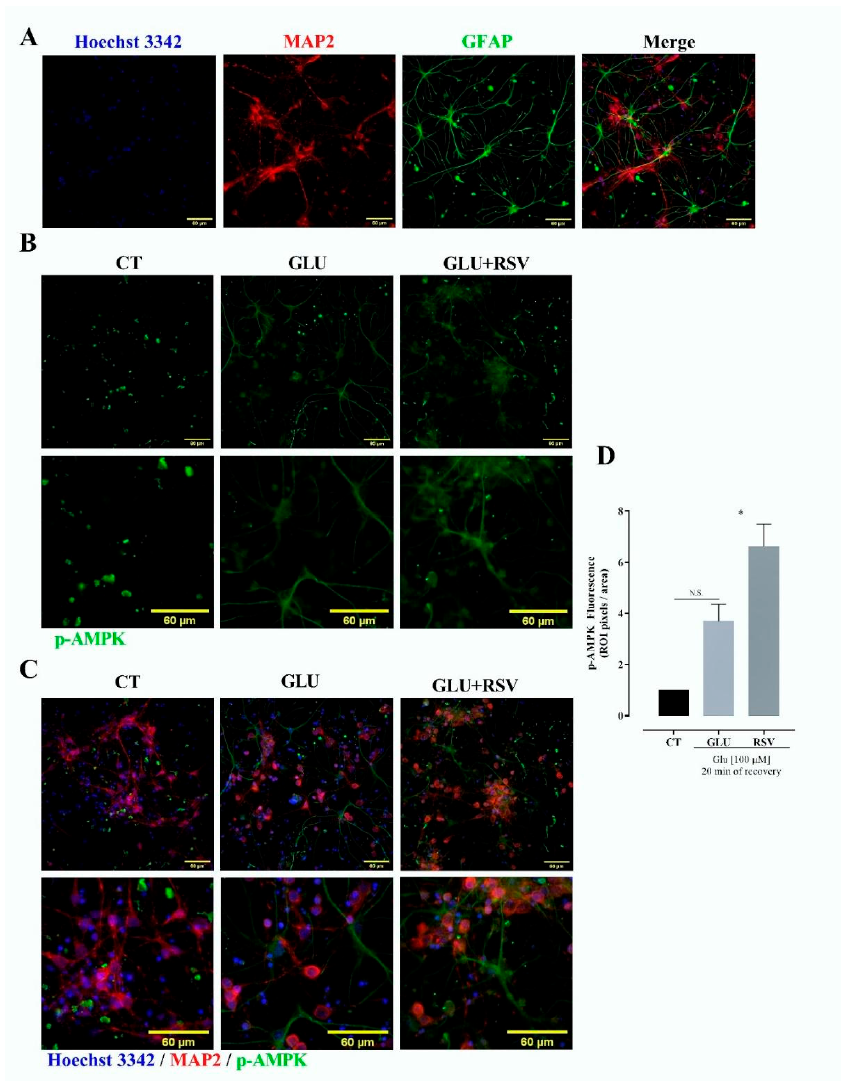
Figure 8. Resveratrol increases AMP-activated protein kinase (AMPK) phosphorylation. Primary mixed cultures of neurons and astrocytes of 7–8 days in vitro were stimulated with 100 µ M glutamate (GLU) and 10 µ M glycine to induce excitotoxicity and allowed to recover for 20 min. Cultures were divided into CT, control; GLU, exposed to excitotoxicity, GLU + RSV, plus resveratrol [40 µ M]. Immunofluorescence. Cultures were stained with Hoechst 33,342 (blue) to identify nuclei, anti- microtubule-associated protein 2 (MAP2) followed by Alexa Fluor ® 594 (red) to identify neurons, and anti- glial fibrillary acid protein (GFAP) or anti phospho AMPK(p-AMPK) followed by DyLight ™ 488 (green) to identify astrocytes or phosphorylate AMPK. ( A ) Detection of the cellular types in the culture. ( B ) Detection of anti phospho AMPK (p-AMPK, green). ( C ) Co-localization of MAP2 and p-AMPK. ( D ) Quantification of the fluorescence for p-AMPK expression. Fluorescence was quantified and reported as “fold” of the intensity of the pixels in a region of interest (ROI). Values of ROI were expressed as mean ± standard deviation. ANOVA, * p < 0.05; N.S., not